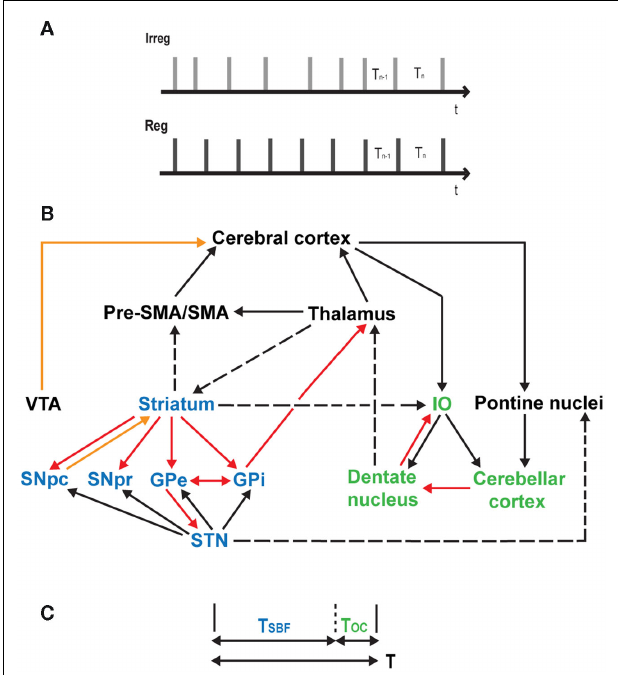
FIGURE 1 | (A) Absolute and relative timing task. Irreg: a sequence of clicks with an average of 15% jitter was used to study absolute, duration-based timing. Participants were required to compare the duration of the final interval, T n to the penultimate interval, T n − 1 where the final interval, T n incorporates a difference ( Δ T ) of 30% of the inter-onset interval (range: 440–560ms) from that of the preceding interval such that T n = T n − 1 ± Δ T 30% . Reg: a sequence of clicks with no jitter is used to study relative, beat-based timing. Participants were required to compare the duration of the final interval, T n to the penultimate interval, T n − 1 where the final interval, T n incorporates a difference ( Δ T ) of 15% of the inter-onset interval from that of the preceding interval such that T n = T n − 1 ± Δ T 15% (cf. Teki et al., 2011 for further stimulus details). (B) A unified model of time perception.The striatal network (in blue) and the olivocerebellar network (in green) are connected to each other via multiple loops, and with the thalamus, pre-SMA/SMA, and the cerebral cortex. Dopaminergic pathways are shown in orange, inhibitory projections in red, excitatory and known anatomical connections in solid and dashed black lines respectively. IO, inferior olive;VTA, ventral tegmental area; GPe, globus pallidus external; GPi, globus pallidus internal; STN, subthalamic nucleus; SNpc, substantia nigra pars compacta; SNpr, substantia nigra pars reticulata. (C) Timing mechanism underlying the unified model.To estimate an interval of duration T , both the striato-thalamo-cortical networks and olivocerebellar networks act in parallel to produce timing signals T SBF and T OC respectively such that the combined output of the system approximates the length of the criterion time interval, T